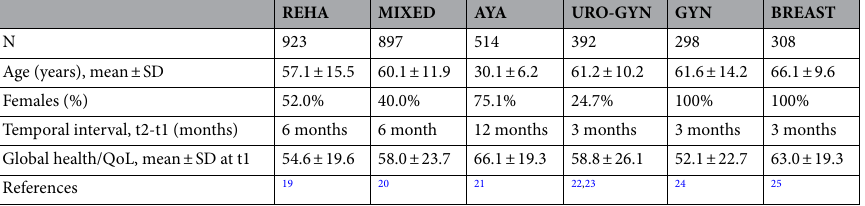
Table 1. Characteristics of the six